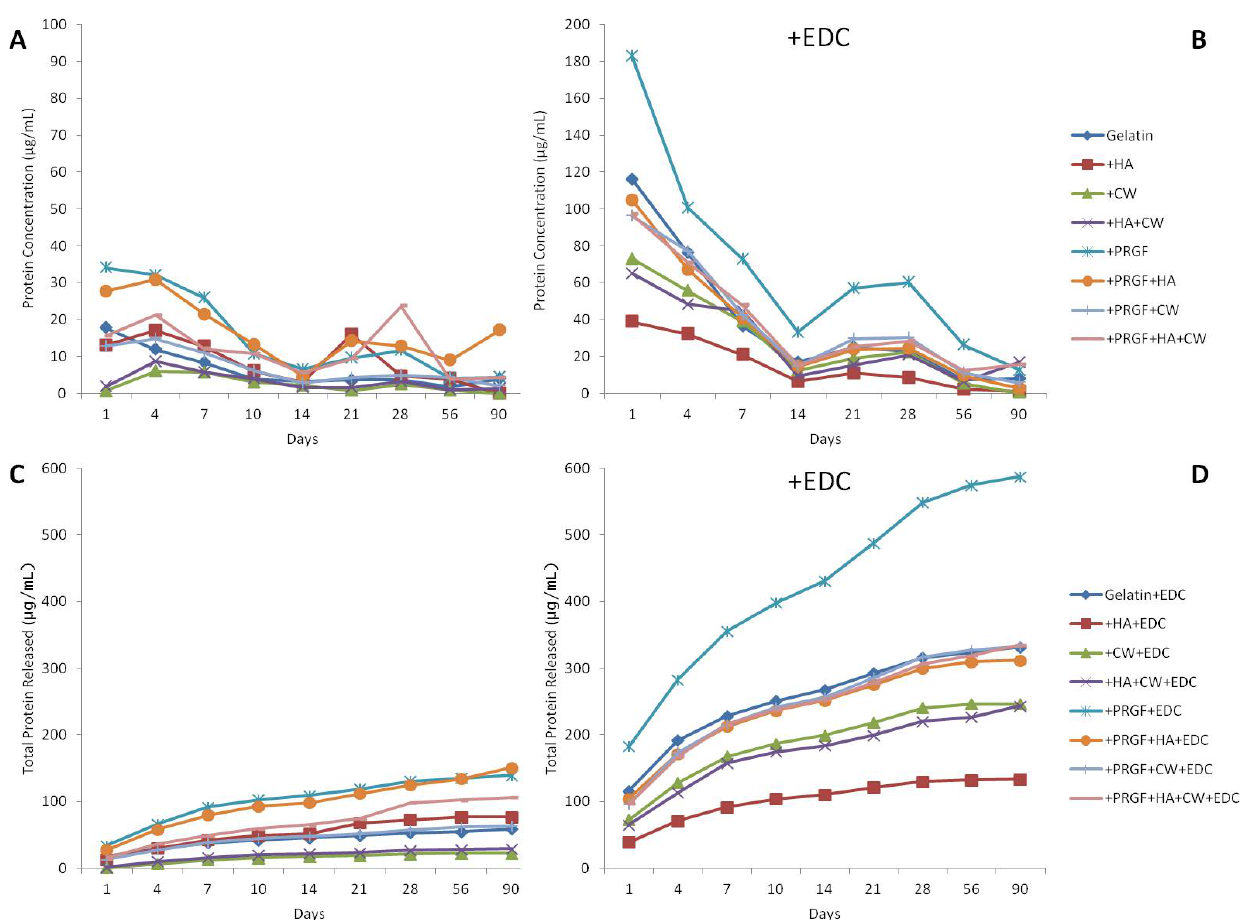
Figure 3. ( A and B ) Protein release of scaffolds per time point. ( C and D ) cumulative protein release over 90